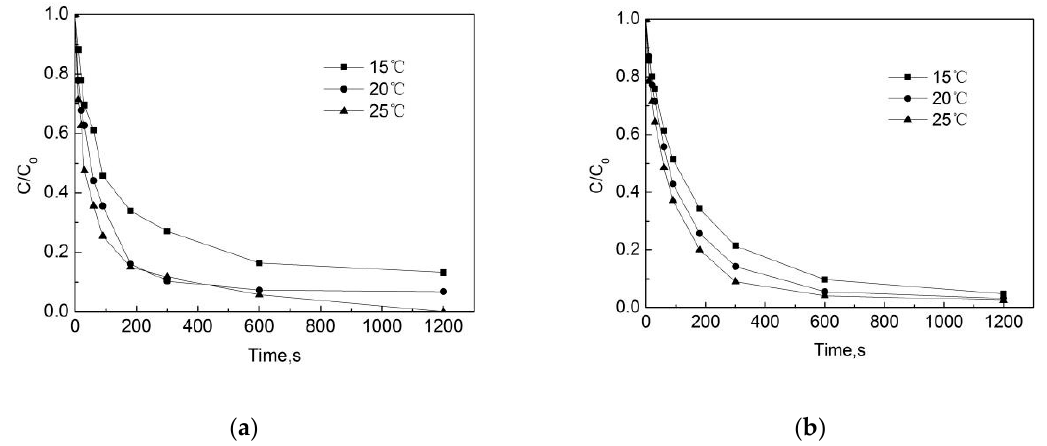
Figure 9. Degradation of OFL under different temperatures in ( a ) the water distribution system, and in ( b ) the deionized water.